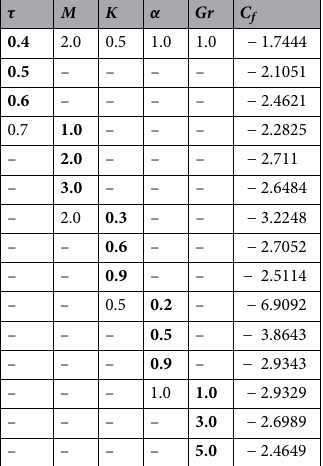
Table 2. Variation of skin friction for different values of parameters. Bold values are used to specify the variation of a particular parameter.